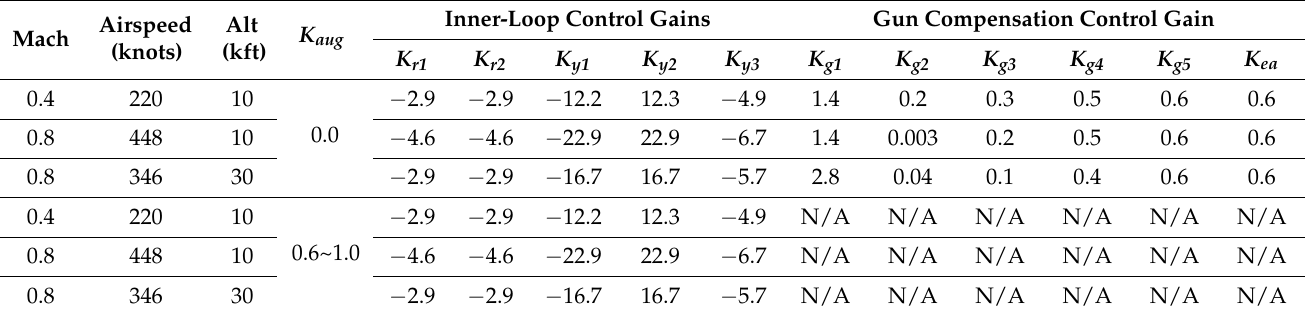
Table 1. Control gains of desired dynamics and gun compensation.